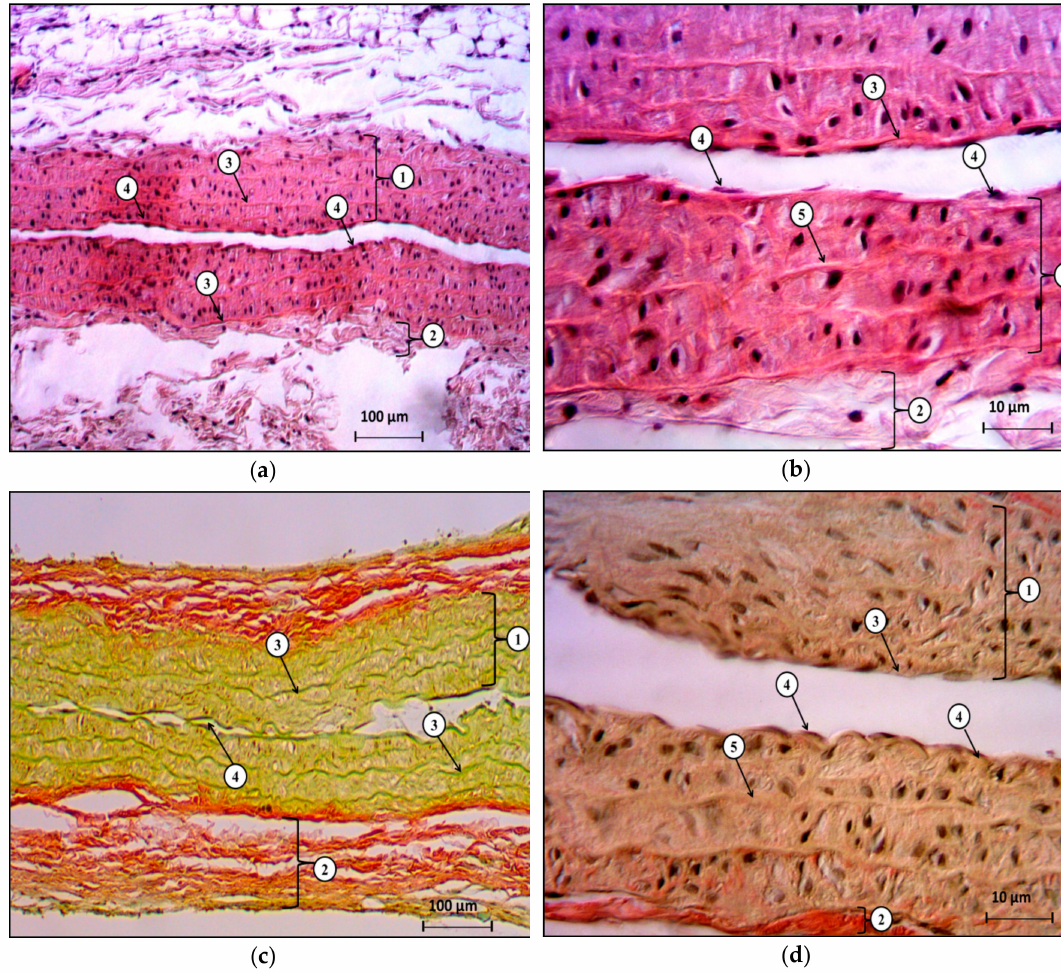
Figure 3. The histological structure of rat abdominal aorta in the control group. ( a )—stained with hematoxylin and eosin, x40; ( b )—stained with hematoxylin and eosin, x400; ( c )—stained by Van Gieson’s method, x40; ( d )—stained by Van Gieson’s method, x400. Designations: ( a ), ( c ): 1—middle shell; 2—outer shell; 3—fenestrated elastic membranes; 4—endotheliocytes located on the basement membrane. ( b ), ( d ): 1—middle shell; 2—outer shell; 3—inner shell; 4—endotheliocytes located on the basement membrane; 5—terminal elastic